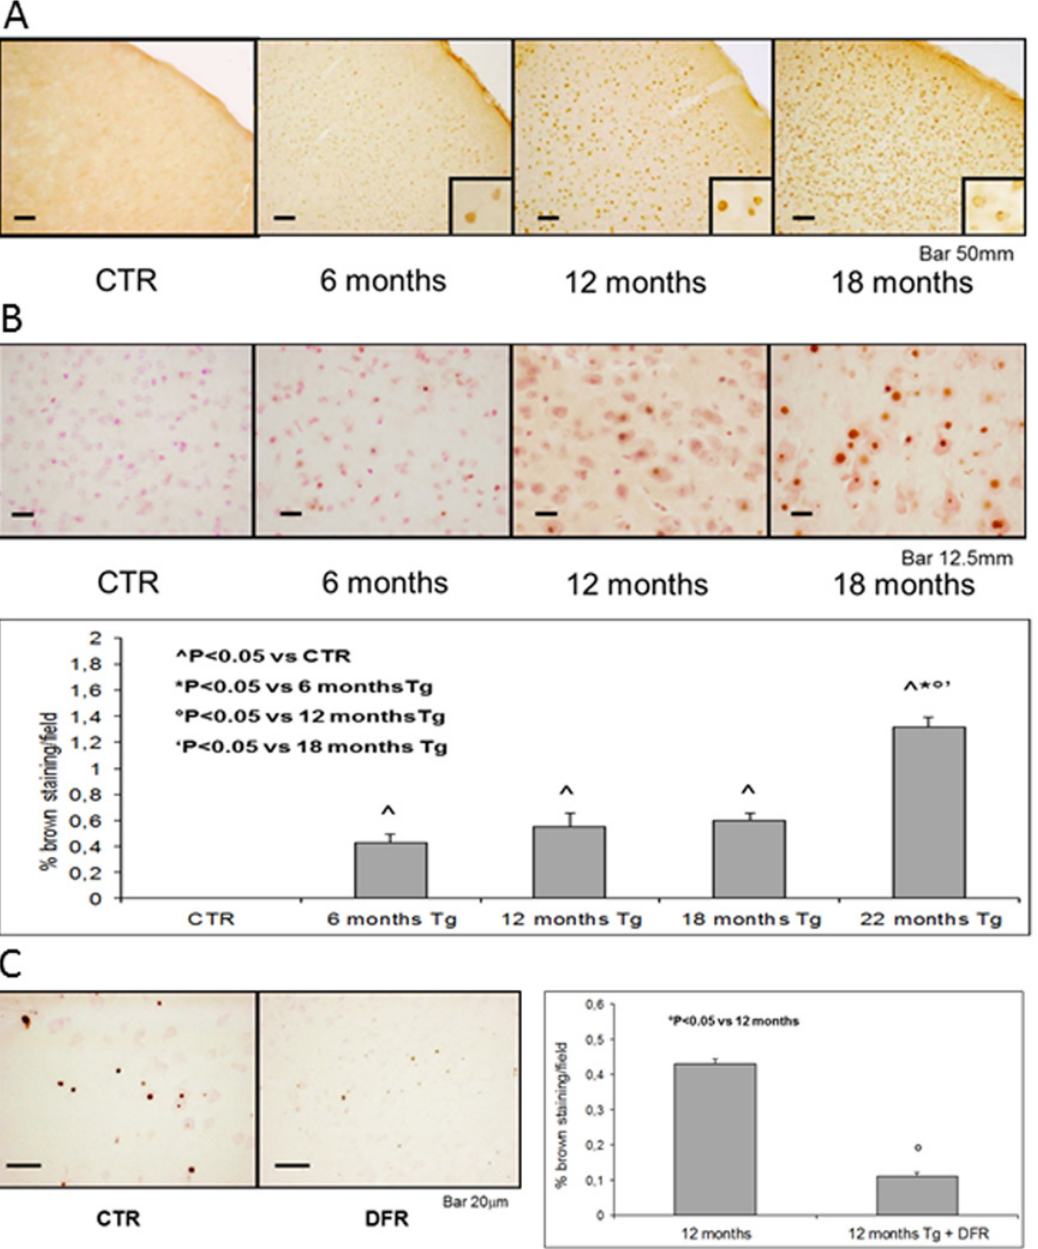
Fig 2. Ferritin and iron accumulation in the brain of Tg-mice. (A) Paraffin-embedded brain sections (40 μ m thick) of Tg and control mice were stained with a specific antibody for human L-ferritin chain. (B) Slices stained with DAB-enhanced Perl ’ s reaction showed a strong accumulation of ferritin/iron bodies in Tg-mouse brains. The quantitative evaluation of the percentage of brown staining in various fields showed the increase of the number and size of the granules with aging. At the optical microscope these granules seemed to be present mostly in neurons, and in the center of the cells in a nuclear/paranuclear position. (C) Mice were treated for 3 weeks with oral iron chelator Deferiprone (DFR) 1 mg/ml in drinking water ad libitum to reduce iron burden. The treatment reduced inclusion bodies in the brain both in number and in size.